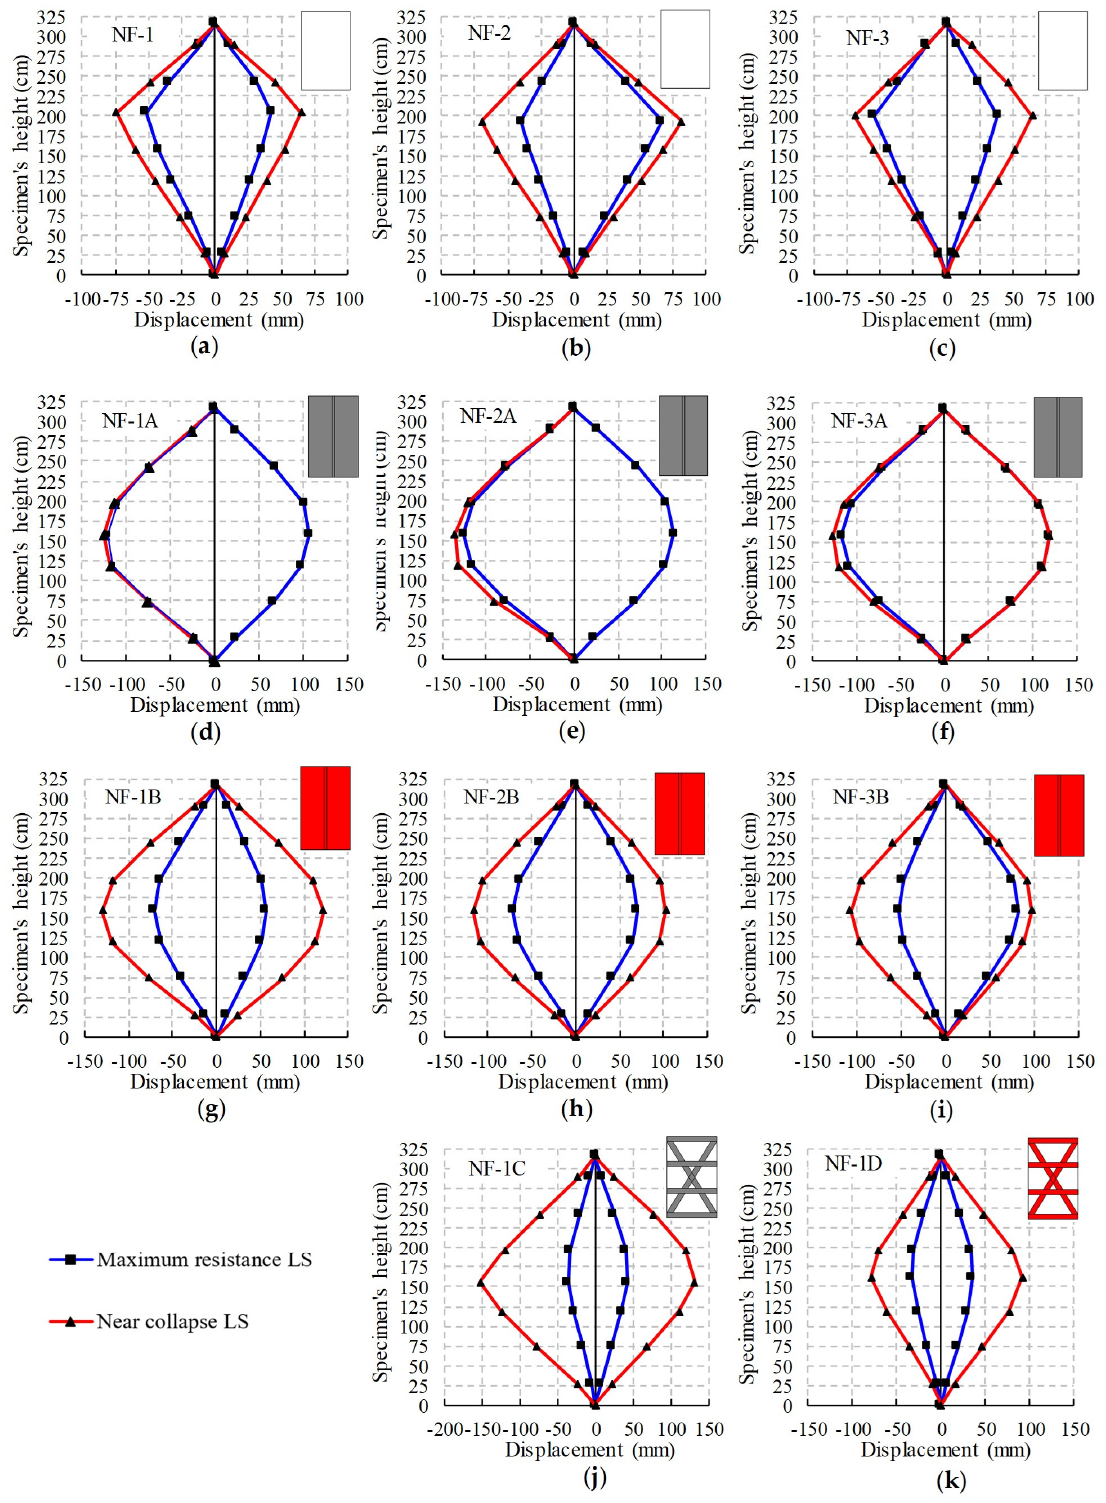
Figure 11. Horizontal displacement profiles along the heights of the specimens at maximum resistance LS (blue line) and near collapse LS (red line): ( a ) NF-1, ( b ) NF-2, ( c ) NF-3, ( d ) NF-1A, ( e ) NF-2A, ( f ) NF-3A, ( g ) NF-1B, ( h ) NF-2B, ( i ) NF-3B, ( j ) NF-C, and ( k )